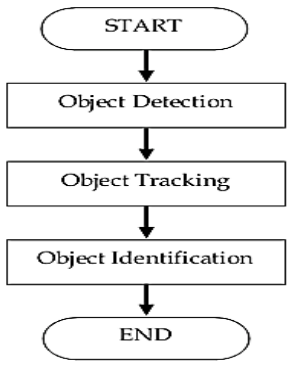
Figure 5. Flow of procedure [49].